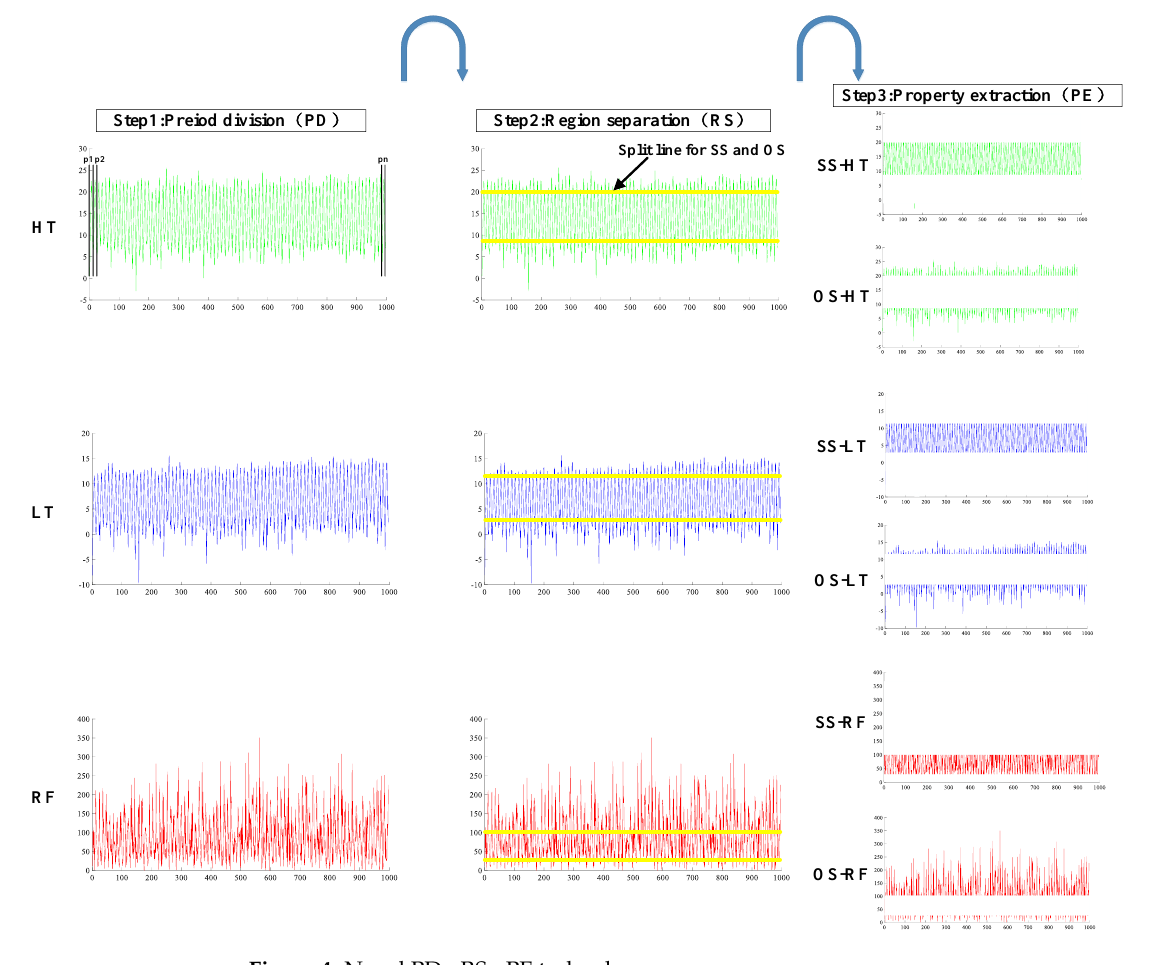
Figure 4. Novel PD − RS − PE technology.